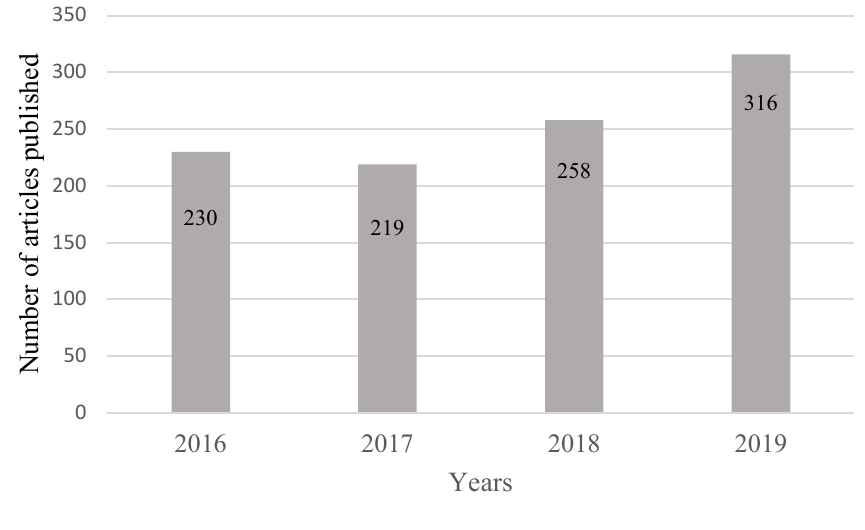
Figure 3. Distribution of studies by publication